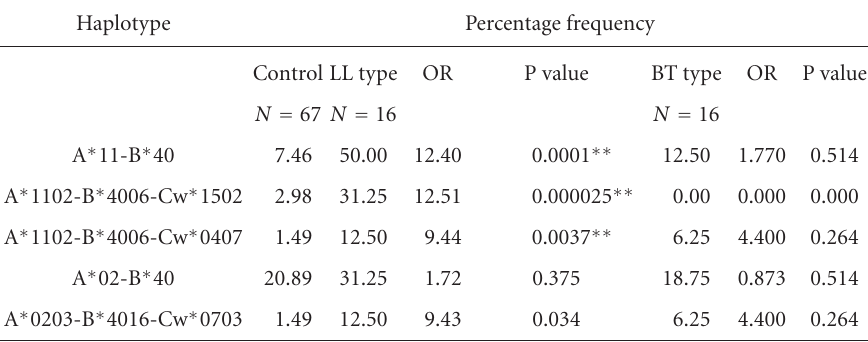
Table 2. Two Significant haplotypes associated with the leprosy patients, Mumbai,